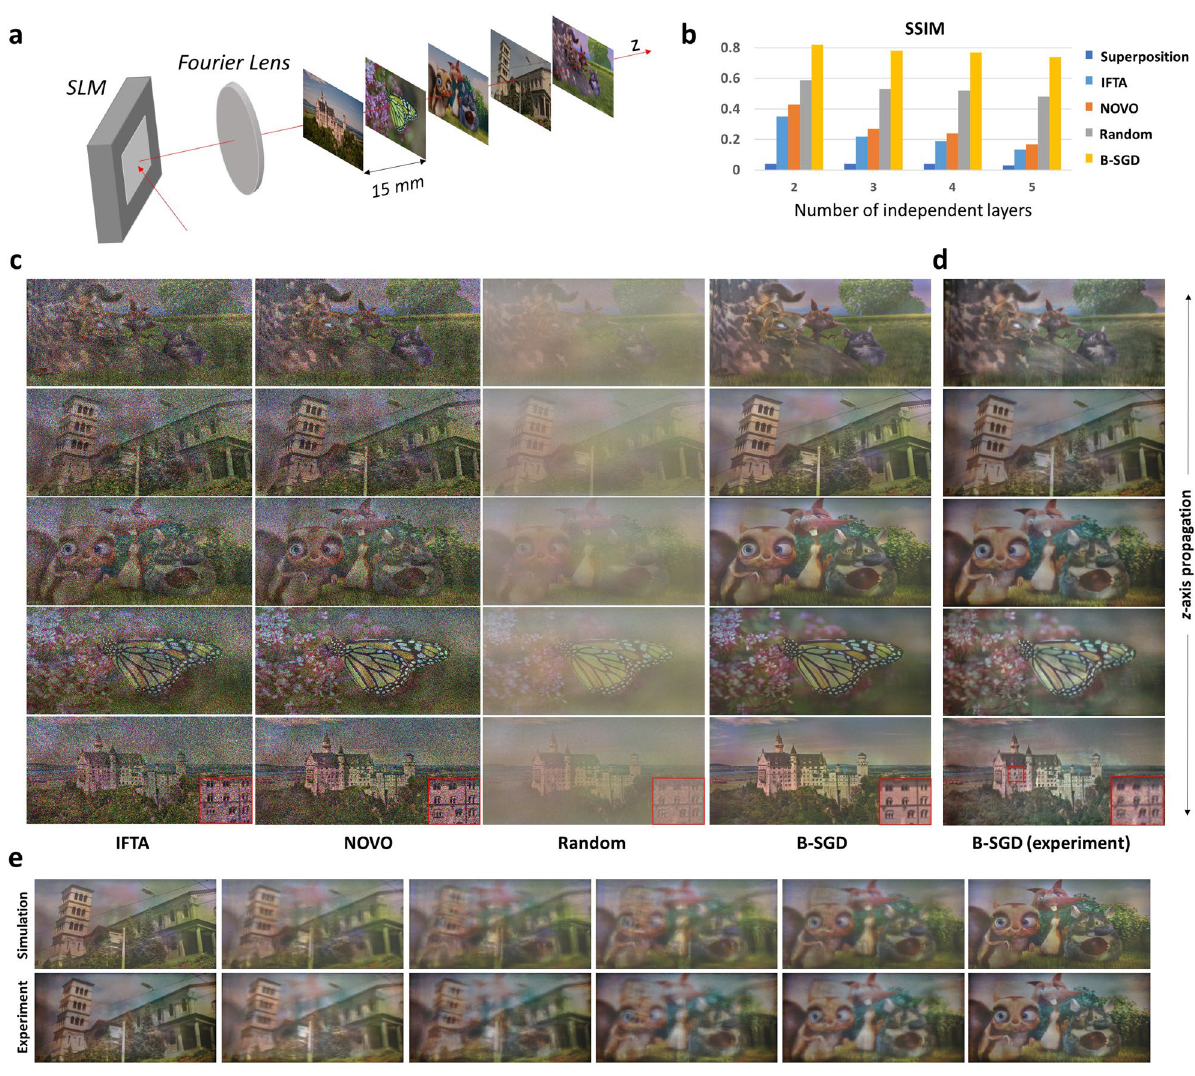
Figure 1. Demonstration and performance evaluation for crosstalk-free 3D projection. ( a ) Scheme of Fourier holographic projection, where five independent images are apart from 15 mm interval. ( b ) Simulated comparison results of five CGH methods, including superposition within phase hologram (superposition), iterative Fourier transform algorithm (IFTA), non-convex optimization (NOVO), superposition within binary hologram (random), and binary-SGD (B-SGD). The binary holographic methods only adopt 24 TM considering dynamic projection. ( c ) Numerical propagation results as focusing on each target depth layers. Only B-SGD shows crosstalk-free projection with high-contrast and low-speckle. ( d ) Experiemental results of proposed B-SGD. ( e ) Intermediate planes of B-SGD method. Source images by Kim, C. et al. 44 , Sheikh, H.R. et al. 45 , and © copyright 2008, Blender Foundation | www. bigbu ckbun ny.